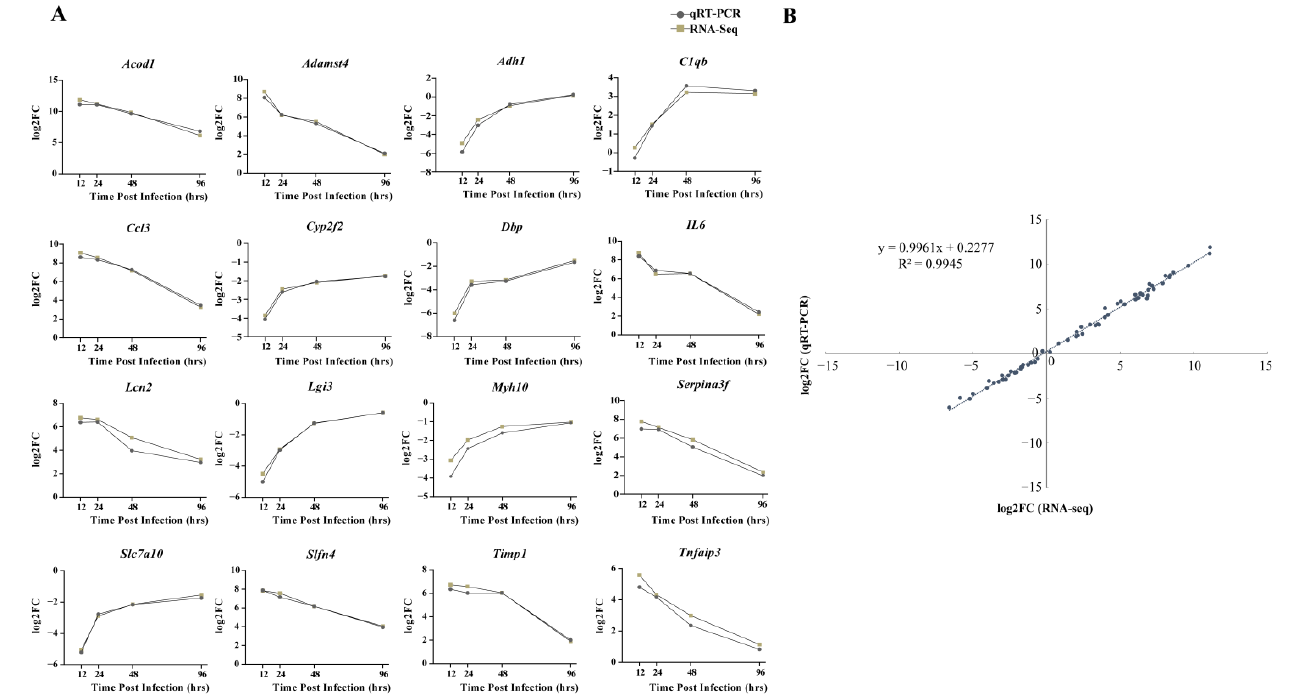
Figure 7. Comparison of relative expression levels measured by RNA-seq and qRT-PCR. ( A ) Sixteen differentially expressed genes (DEGs) were selected for verification. The relative expression of each gene was calculated by the 2- ∆∆ Ct method (fold change). The Y -axis shows the fold changes com- pared to the starting point in different stages of infection, with positive values indicating upregulation and negative values indicating downregulation. ( B ) Correlation between fold changes obtained by qRT-PCR ( X -axis) and RNA-seq platform ( Y -axis). Each data point was obtained from three biological replicates. Graphpad 8.0 was used to process and plot the data.